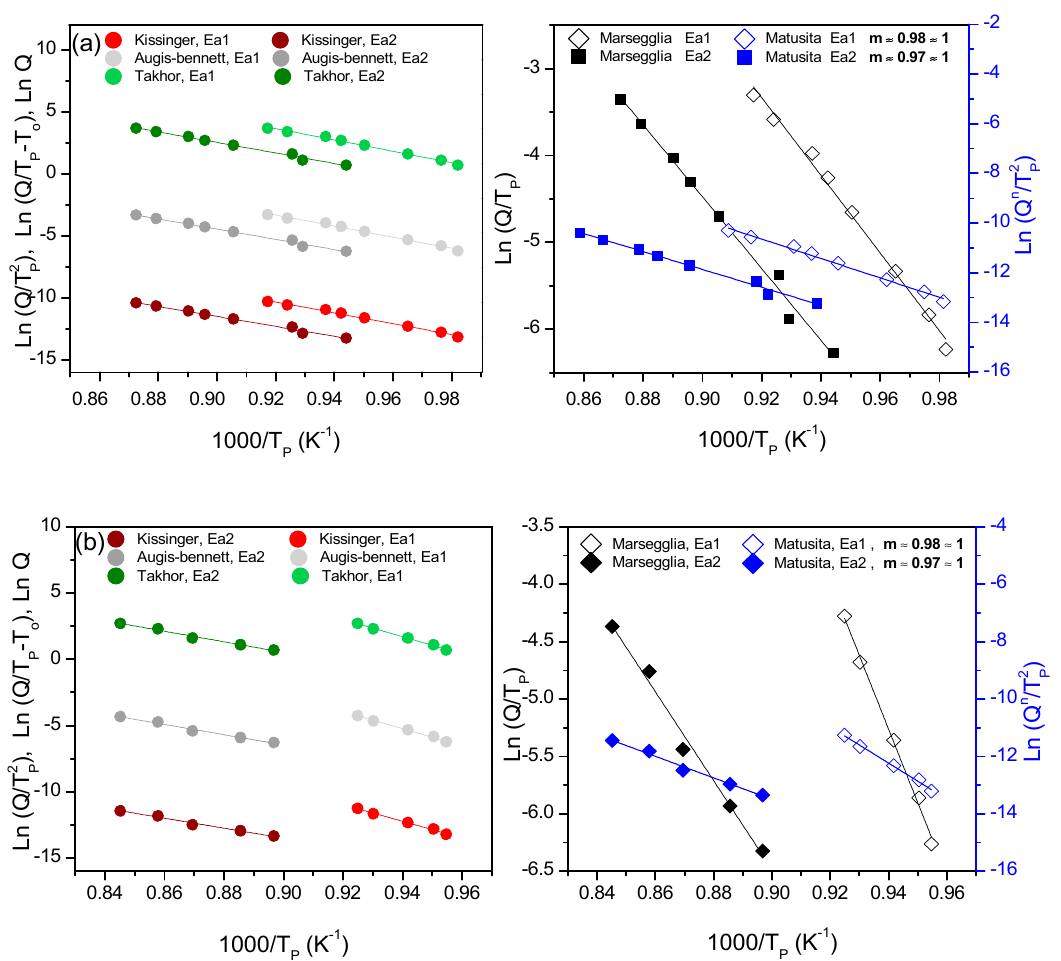
Figure 6. Representations of Kissinger, Augis-Bennet and Takhor on the left and representations of Marseglia and Matusita on the right for the two crystallization peaks and the fine particle size for composition ( a ) 7.5B(Ba) and ( b ) 10B(Sr).